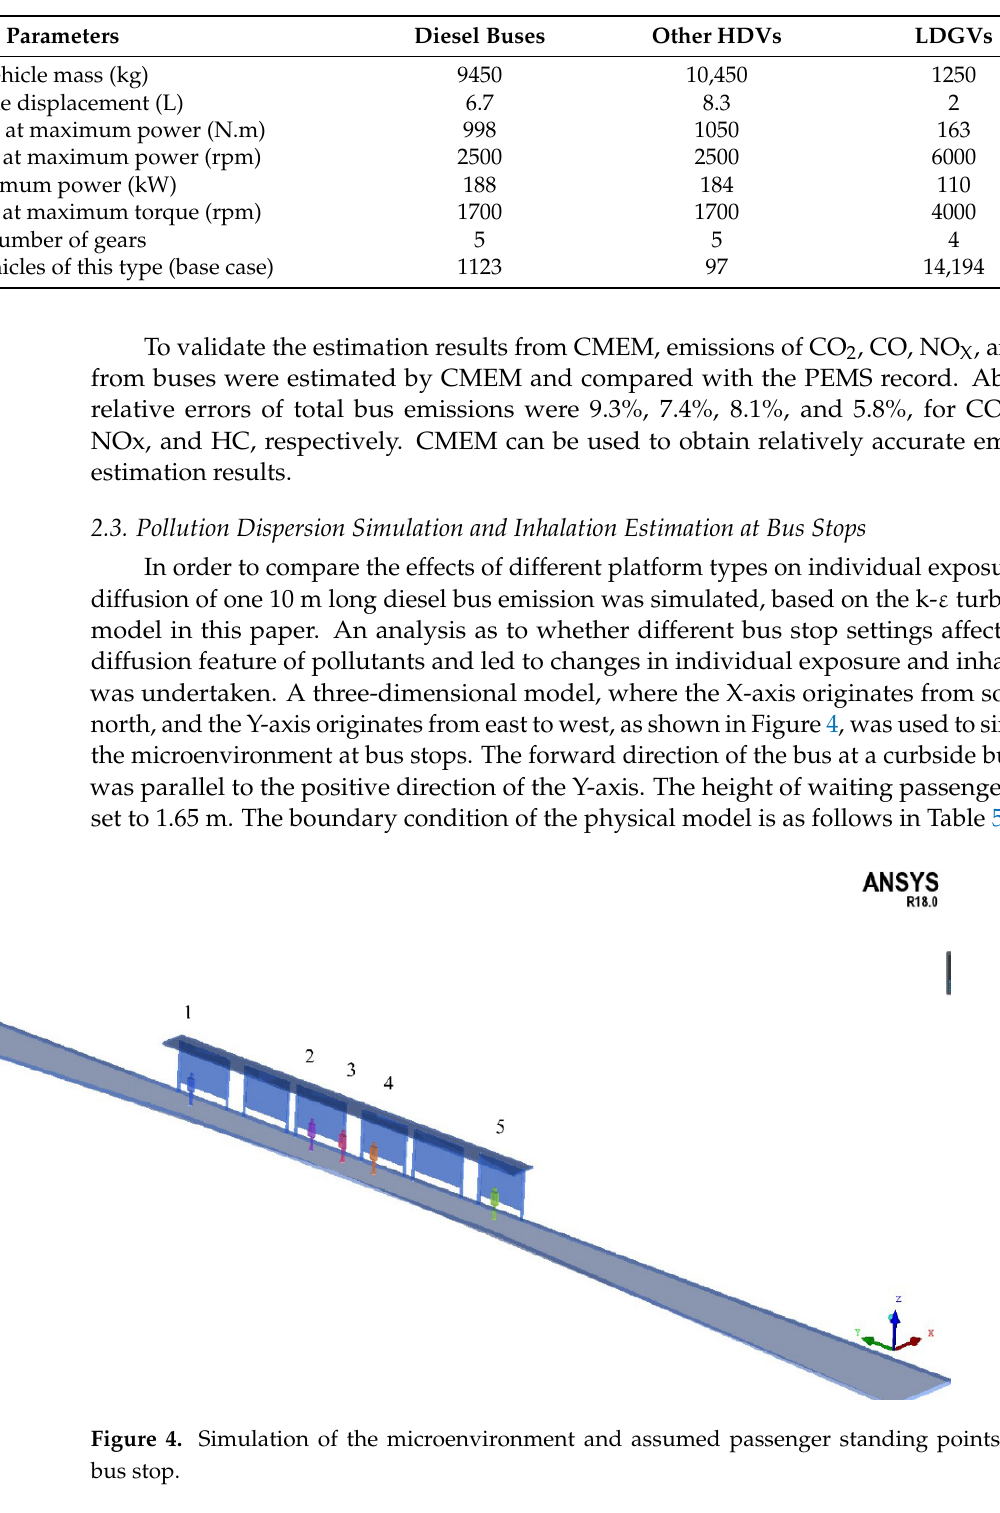
Table 4. Inputs used for emissions estimation in CMEM.